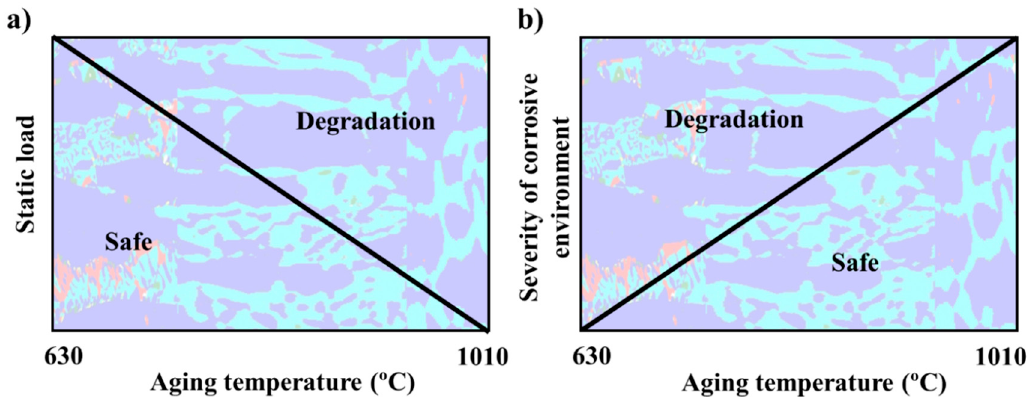
Figure 16. Overview of the degradation of microstructures with different σ morphologies, as a background, and a composite EBSD phase map of σ -containing microstructures is presented. ( a ) Resistance against static external load; ( b ) corrosion resistance.